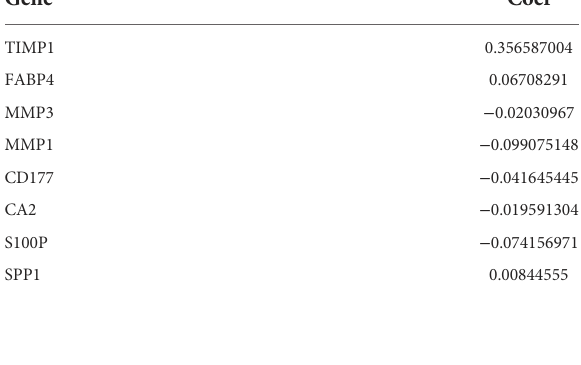
TABLE 4 The gene coef fi cients obtained from LASSO